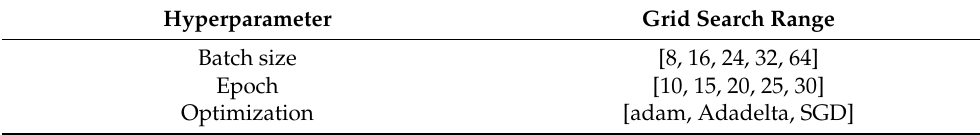
Table 2. Grid search algorithm parameter se tt ing. Table 3. The running time of model.